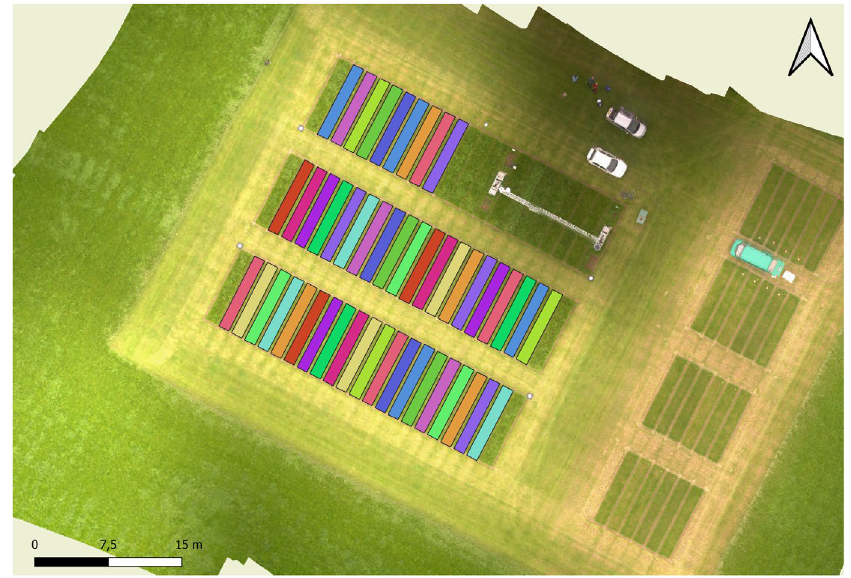
Figure 1. An orthomosaic of the study area. Colored rectangles indicate the plots. Each color refers to a fertilization